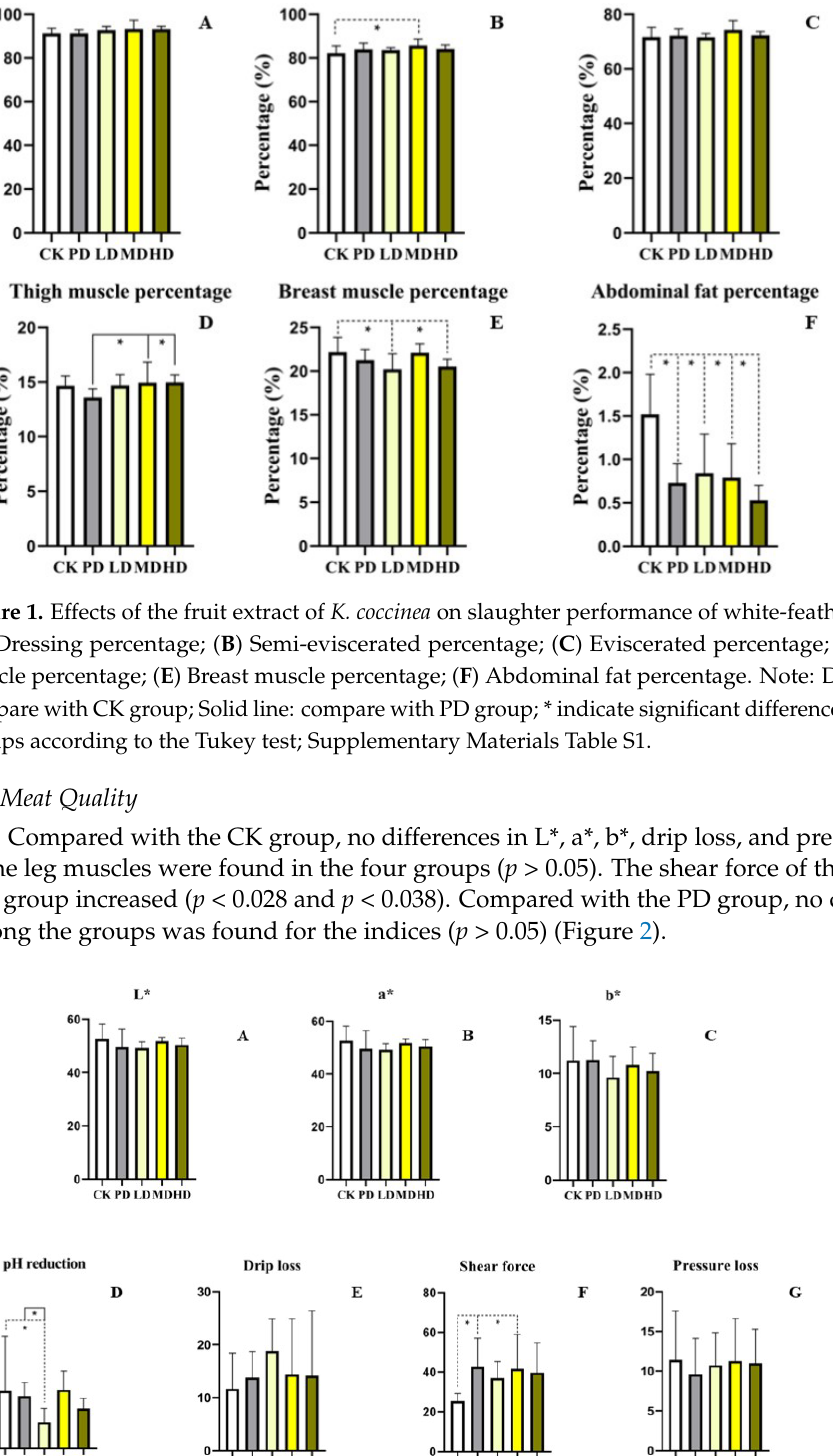
Figure 2. Effects of the fruit extract of K. coccin ea on leg muscle of white-feather broilers ( A ): L*; ( B ): a*; ( C ): b*; ( D ): pH reduction of 24 h; ( E ): drip loss; ( F ): shear force; ( G ): pressure loss; Note: Dotted line: compare with CK group; Solid line: compare with PD group; * indicate significant differences between groups according to the Tukey test; Supplementary Materials Table S2.